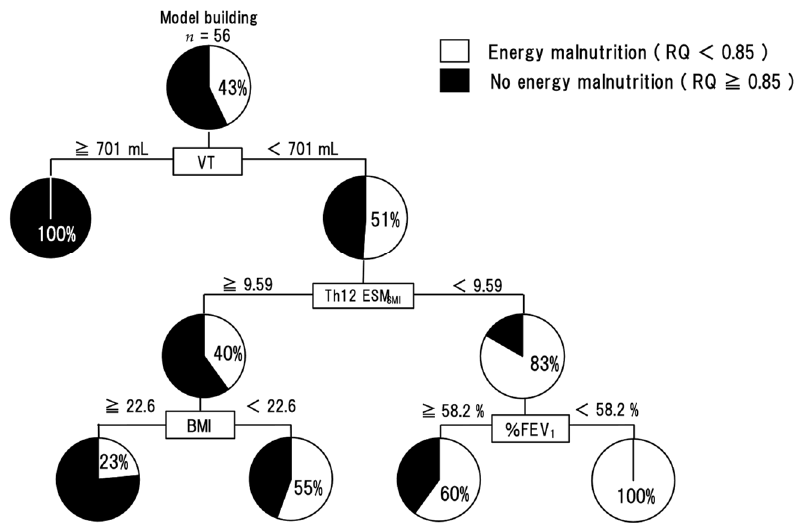
Figure 2. A decision-tree analysis for energy malnutrition. The pie graphs indicate the proportion of subjects with RQ < 0.85 (white) and subjects with RQ ≥ 0.85 (black). Abbreviation: RQ—respiratory